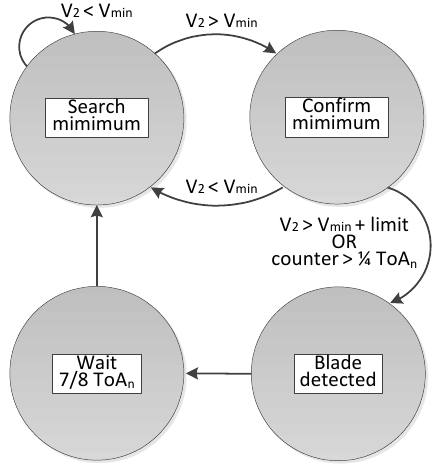
Figure 7. Pseudo-­‐‑state machine to detect global minima. Figure 7. Pseudo-state machine to detect global